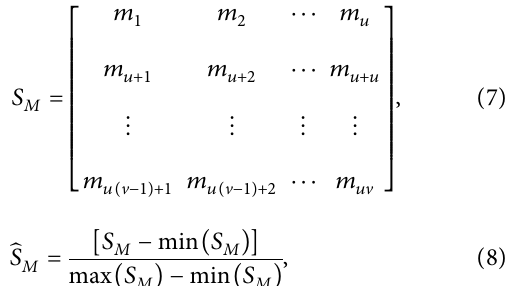
Algorithm 1 lists the pseudocode of the proposed